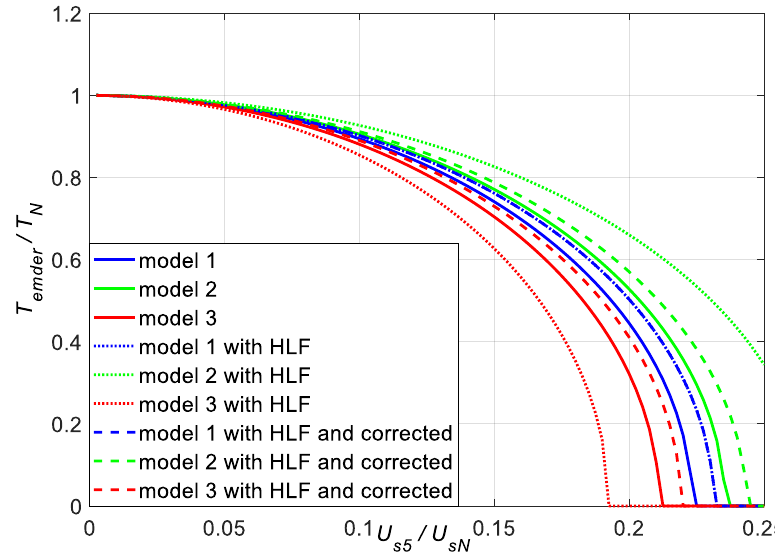
Figure 7. Derating torque of the motor as a function of the RMS value of the 5th harmonic of the supply voltage—comparison of curves from Figure 4 with curves obtained based on HLF.